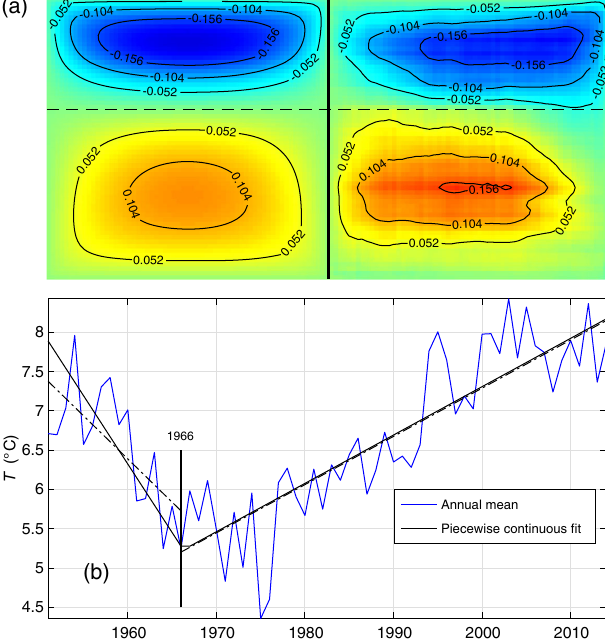
FIG. 17. Inference from Q of a break in slope. (a) The slight left-right asymmetry in the pattern at the top right (USW00023050 Albuquerque International Airport, NM) is a FIG. 16. Quadratic vs piecewise linear profiles and break harbinger of mode 2 in Fig. 6, with a downward trend in σ of detection: Two profiles are shown in the inset: the quadratic, about 0 . 4 °C. (b) Q and LS detrending of the left-hand segment alone give a different slope than results from this piecewise ð y þ 3 = 5 Þ 2 , and a piecewise linear profile matching the endpoint ¯ Q (cid:5) continuous correction, thereby suggesting a breakpoint. values and zero minimum at y ¼ − 3 = 5 . (a) Ensemble means computed for iid normal noise with σ ¼ 2 . The antisymmetric cubic profile is consistent with the detrended quadratic, which is ¯ Q (cid:5) centered at the origin, while the zero crossing of for the detrended piecewise case maps accurately using Eq. (A2) to − 3 = 5 . (b) − d ¯ Q (cid:5) =dy , when linearly rescaled, works well for both detrended profiles. If a bimodal pattern of Q emerges after ¯ Q detrending with a zero crossing of significantly displaced from the middle, this is, likely, a discontinuity in the time series at the indicated node (as inferred in Fig. 11), caused by, e.g., changes in thermometry or station location. In such